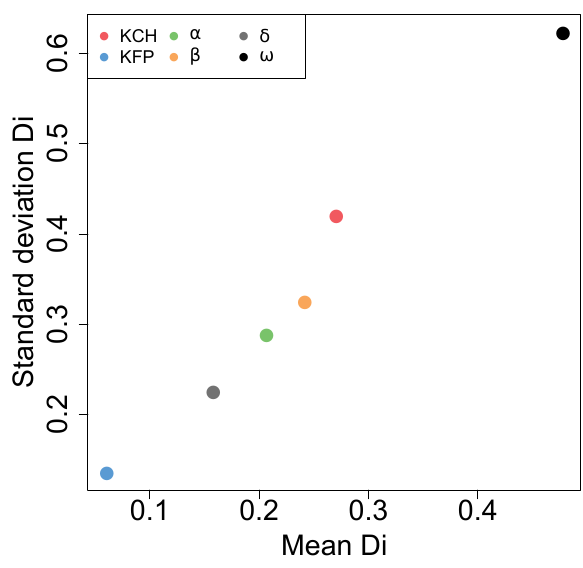
Figure A1. Results of the Morris method applied to MHYST with a 50m resolution DEM on the Loing catchment for the six parameters ( K fp , K ch , α , β , ω , δ